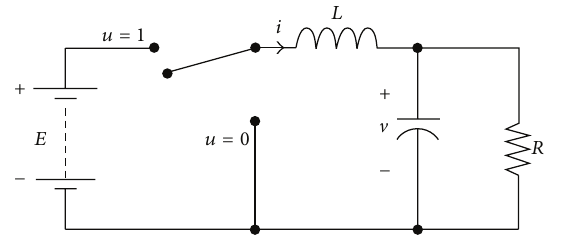
Figure 4: Ideal switch representation of the DC/DC buck converter.